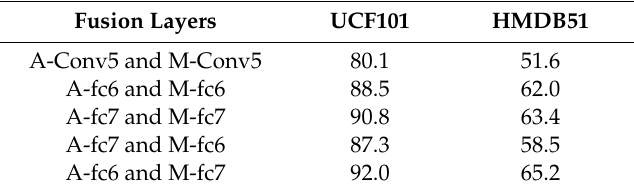
Table 3. The accuracies (%) of di ff erent fusion strategies for two streams on UCF101 and HMDB51. “A-” means the layer from the appearance stream, and “M-” means the layer from the motion stream.